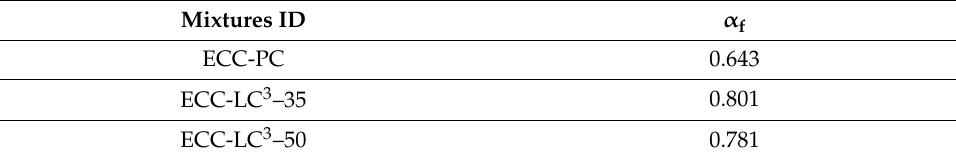
Table 8. Fiber dispersion coefficient.